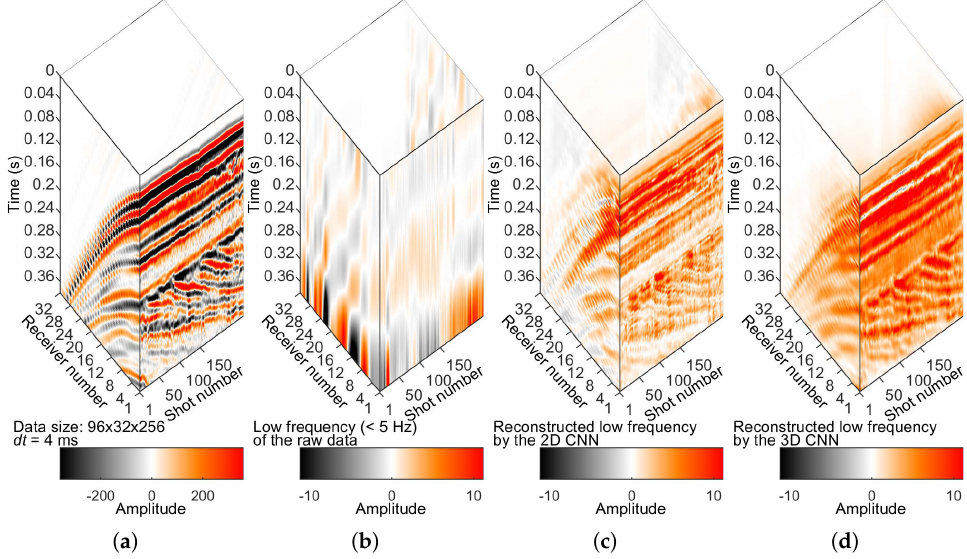
Figure 9. Experiments on the Mobil AVO Viking Graben Line 12 data. ( a ) Prestack seismic data. ( b ) Low-frequencies (<5 Hz) of the raw data shown in ( a ). ( c ) Predicted low-frequencies by 2D CNN. ( d ) Predicted low-frequencies by 3D